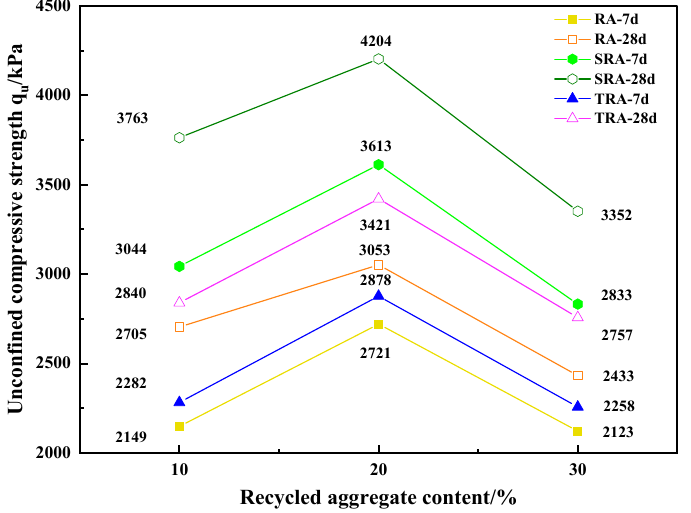
Figure 5. Change curve of unconfined compressive strength of samples with different particle grading recycled aggregate contents.